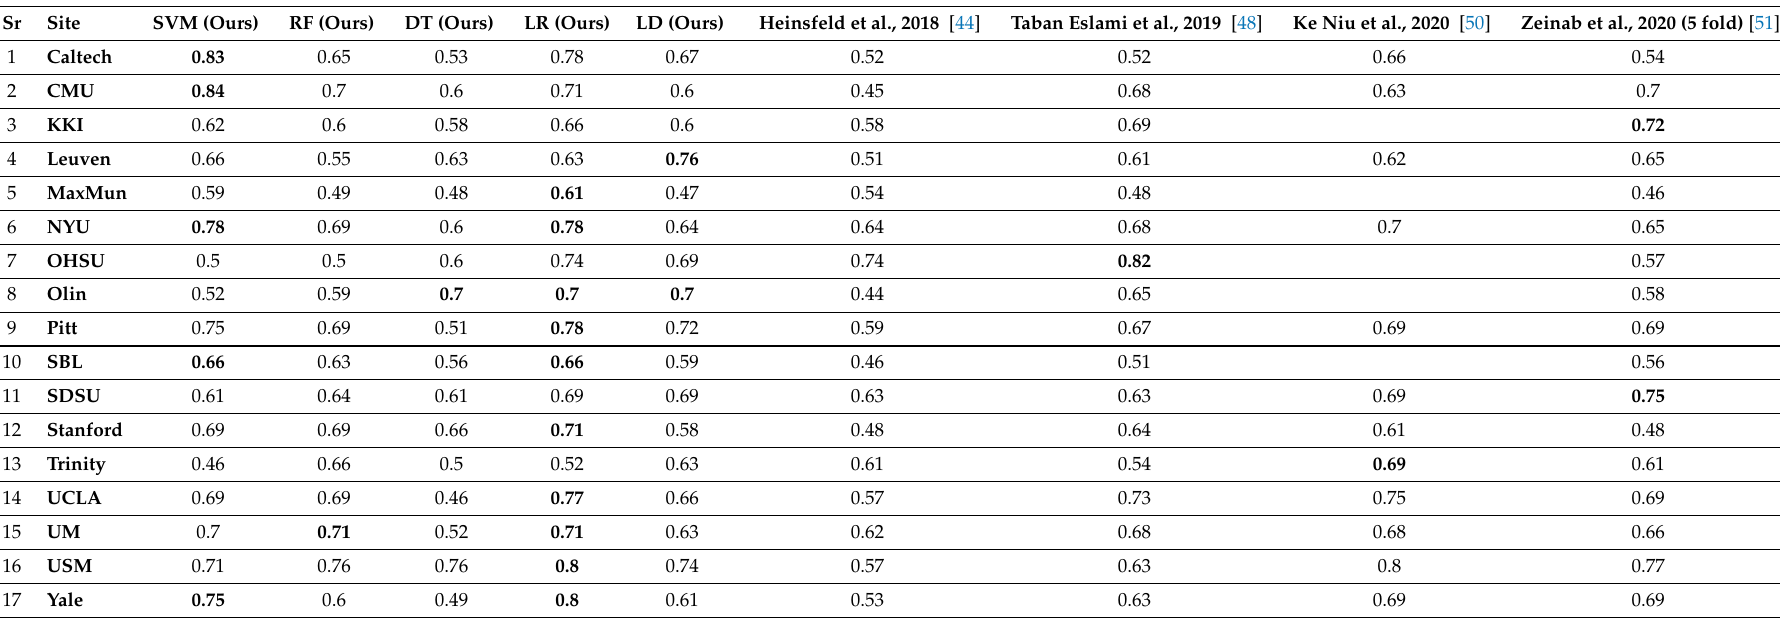
Table 12. Proposed 3-Stage selected features’ 5-Fold Accuracy Comparison on each individual Site